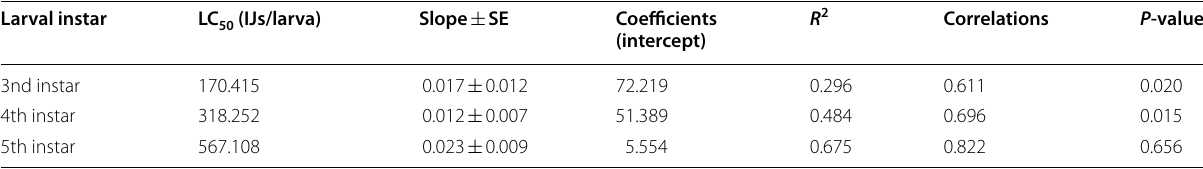
Table 1 Pathogenicity of Steinernema carpocapsae nematode against different larval instars of Spodoptera frugiperda at different concentrations (IJs/ml) after 48 h of